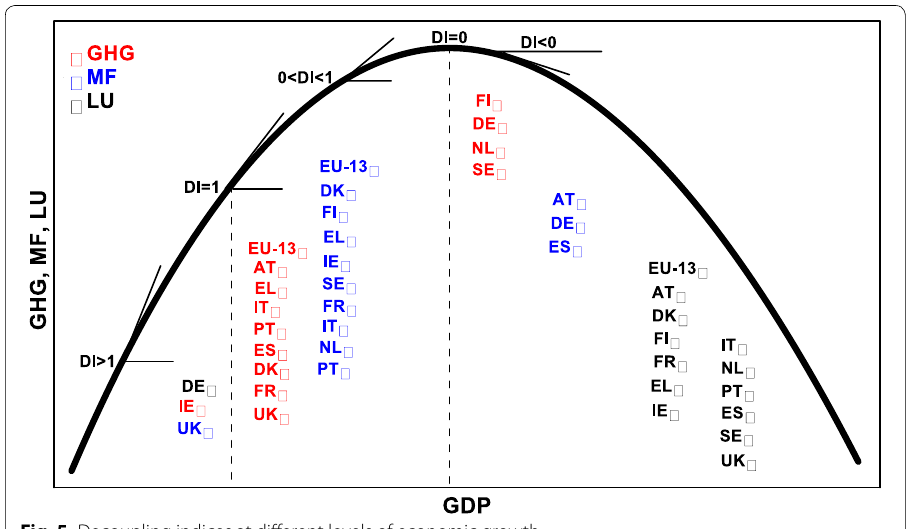
Fig. 5 Decoupling indices at different levels of economic